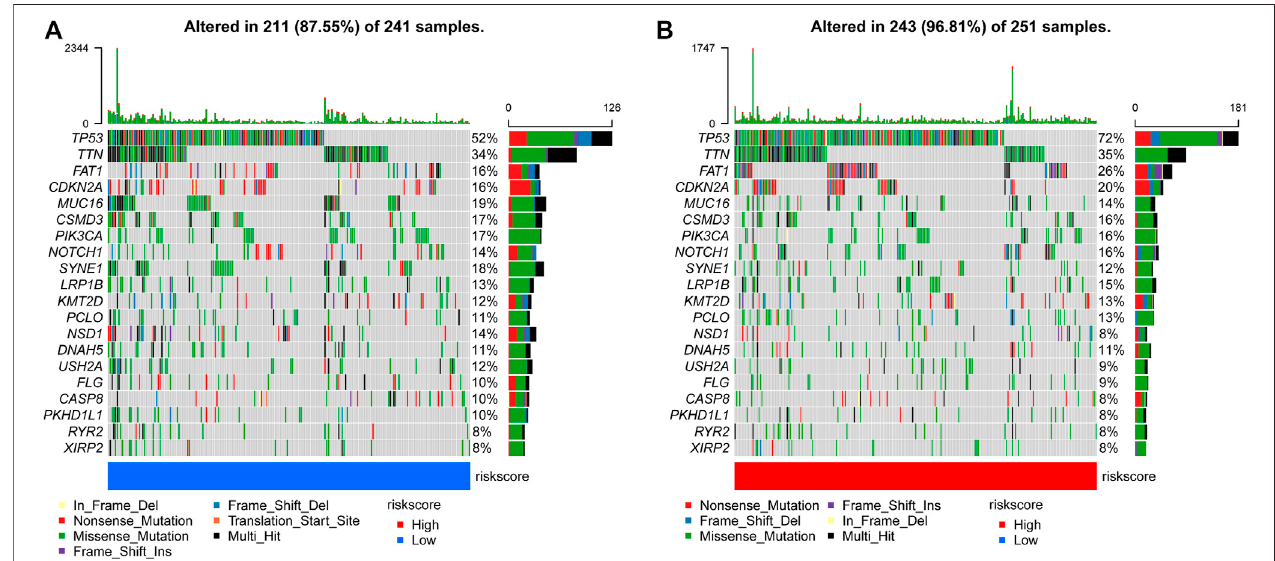
FIGURE8| Comparison ofmutationsinthelow-riskgroupandhigh-riskgroup (A,B) Thetop20mostfrequentlymutatedgenesinthelow-riskgroupandhigh-riskgroup.